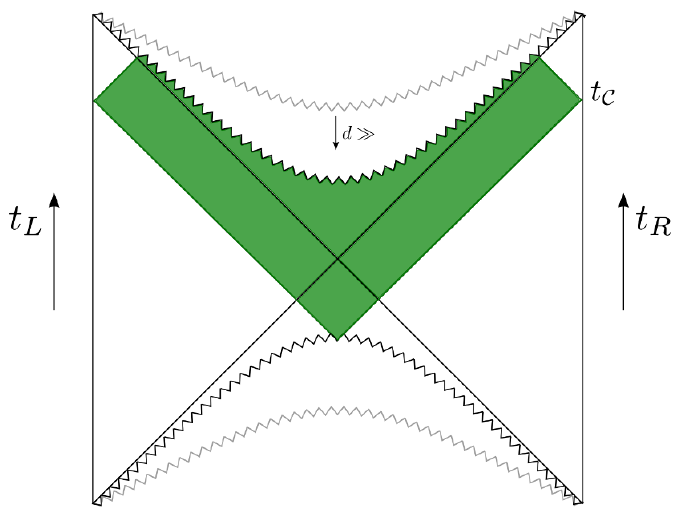
Figure 3 . Conformal diagram for higher dimensional black holes and WdW patch at the moment of computation